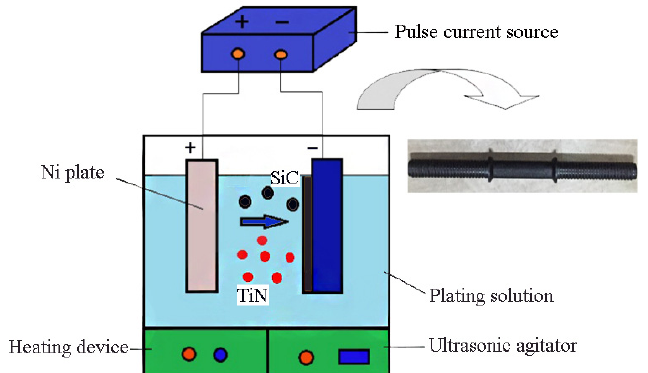
Figure 1. Experimental set-up for fabrication of Ni/TiN-SiC nanocoatings.